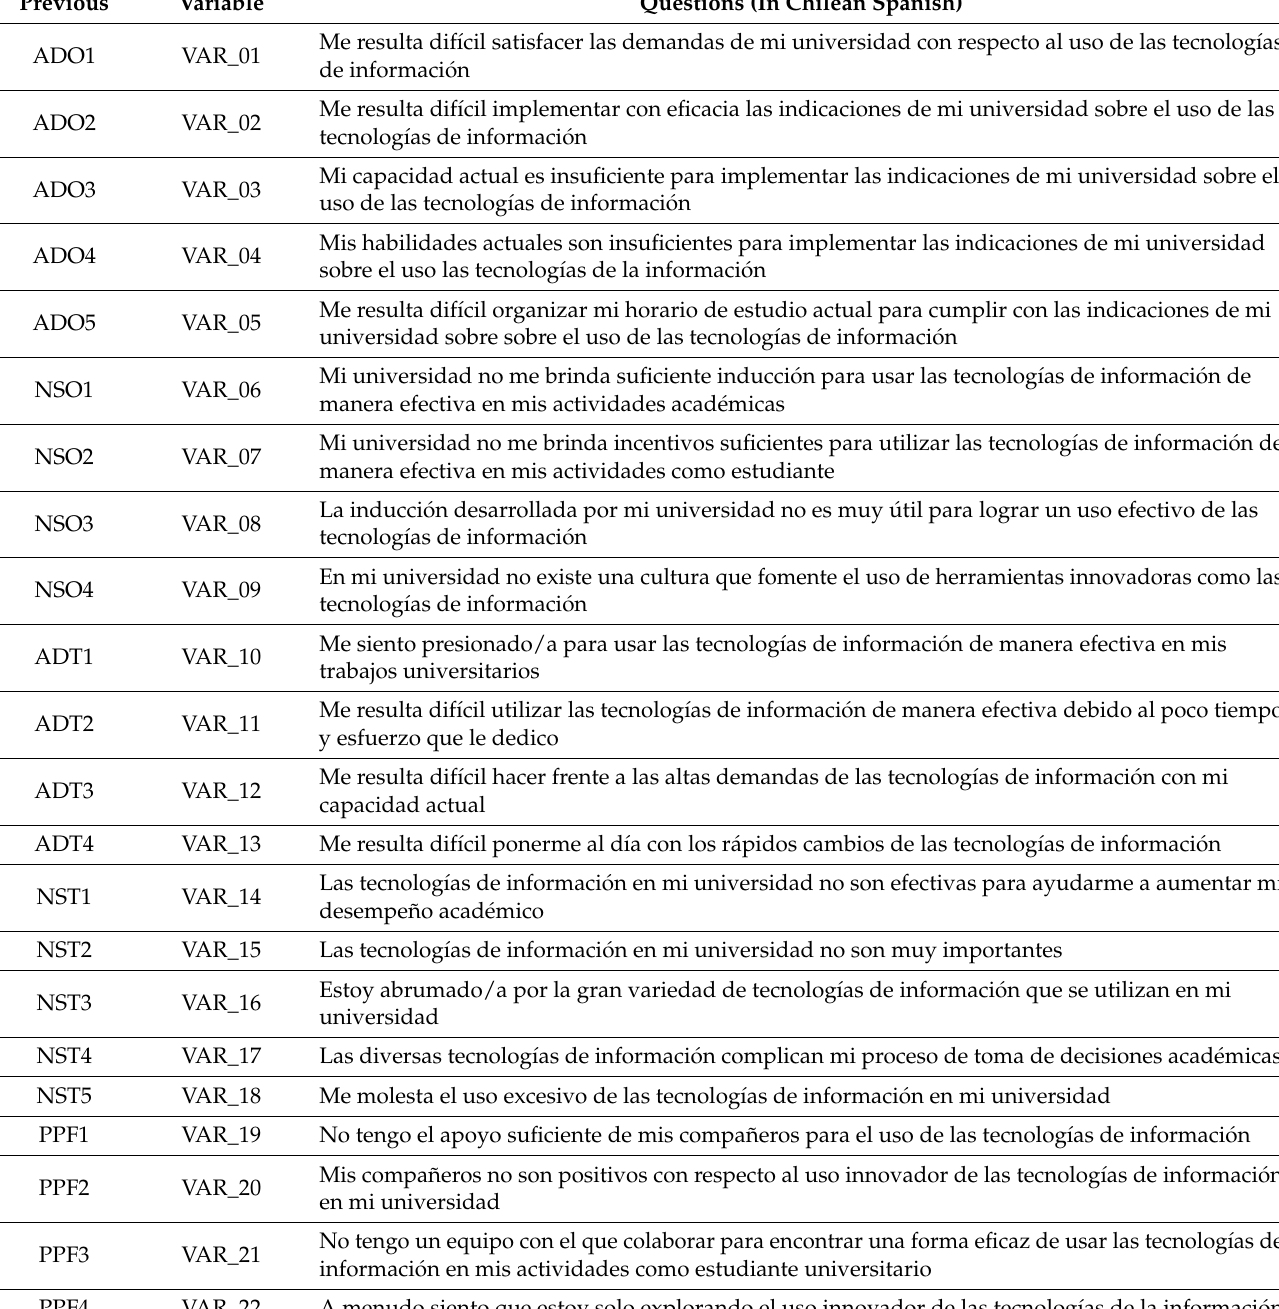
Table A1. Applied Technostress